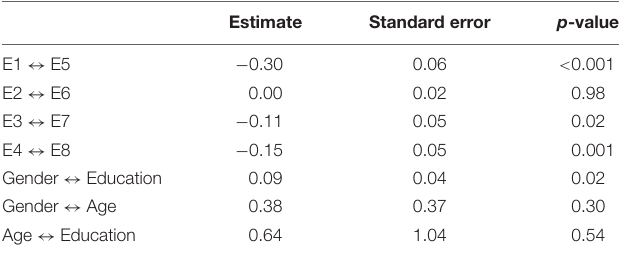
TABLE 5 | Regression weights (unstandardized) for covariates in the autoregressive cross-lagged model. Estimate Standard error p